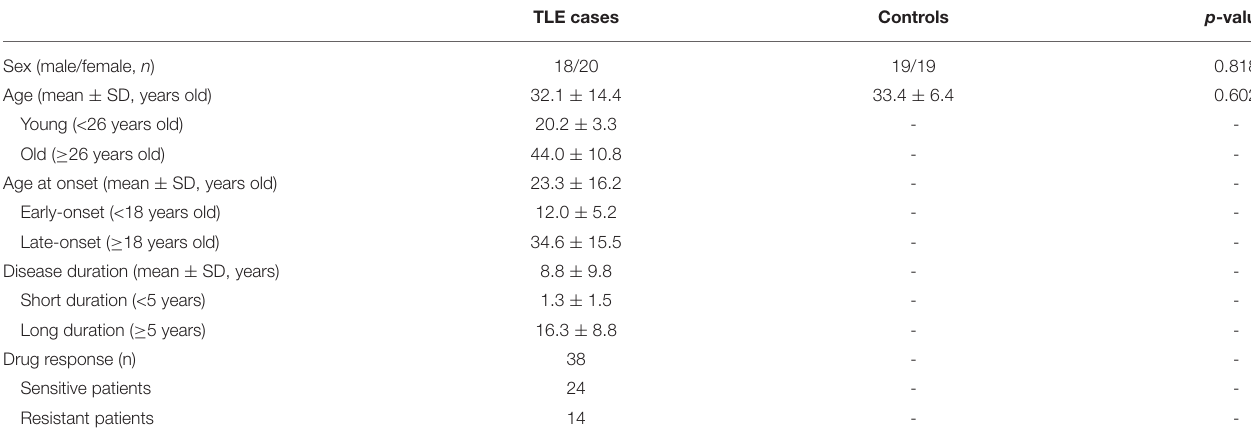
TABLE 1 | General characteristics of enrolled individuals.